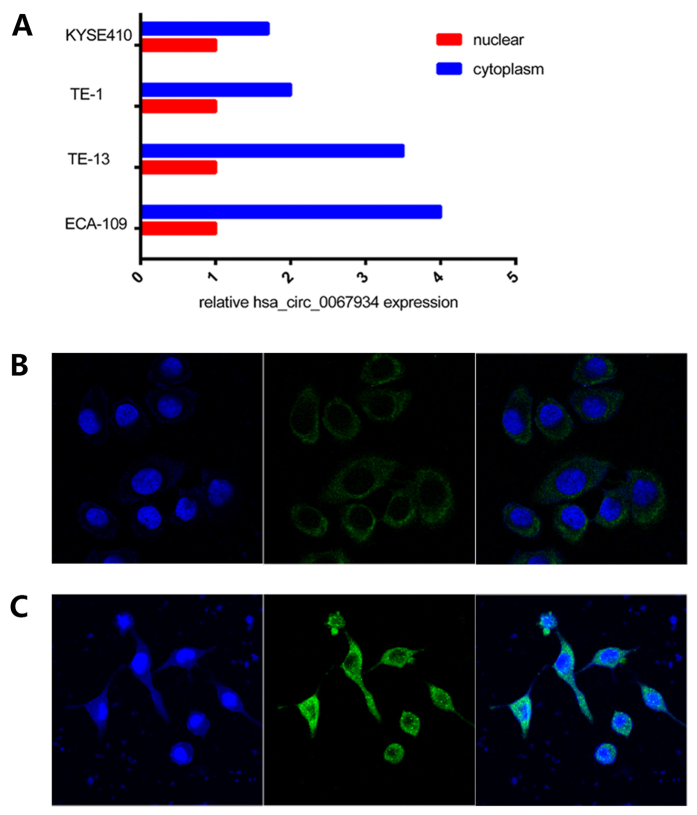
Identify the localization of hsa_circ_0067934 in ESCC cells.(A) The majority of hsa_circ_0067934 was located in the cytoplasm through the nuclear mass separation experiment; FISH assay also shown has_circ_0067934 was mostly located in cytoplasm of ECA109 (B) and TE-13 cells (C).